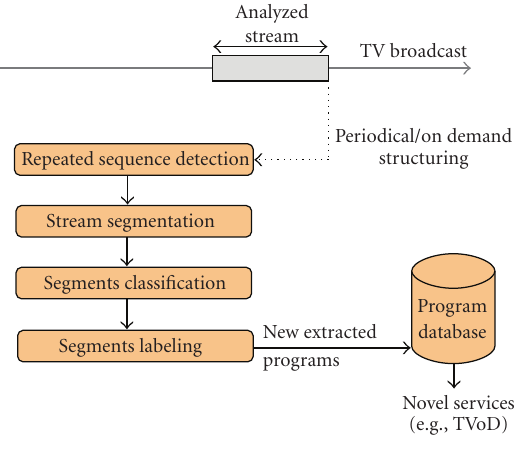
Figure 3: Structuring steps of